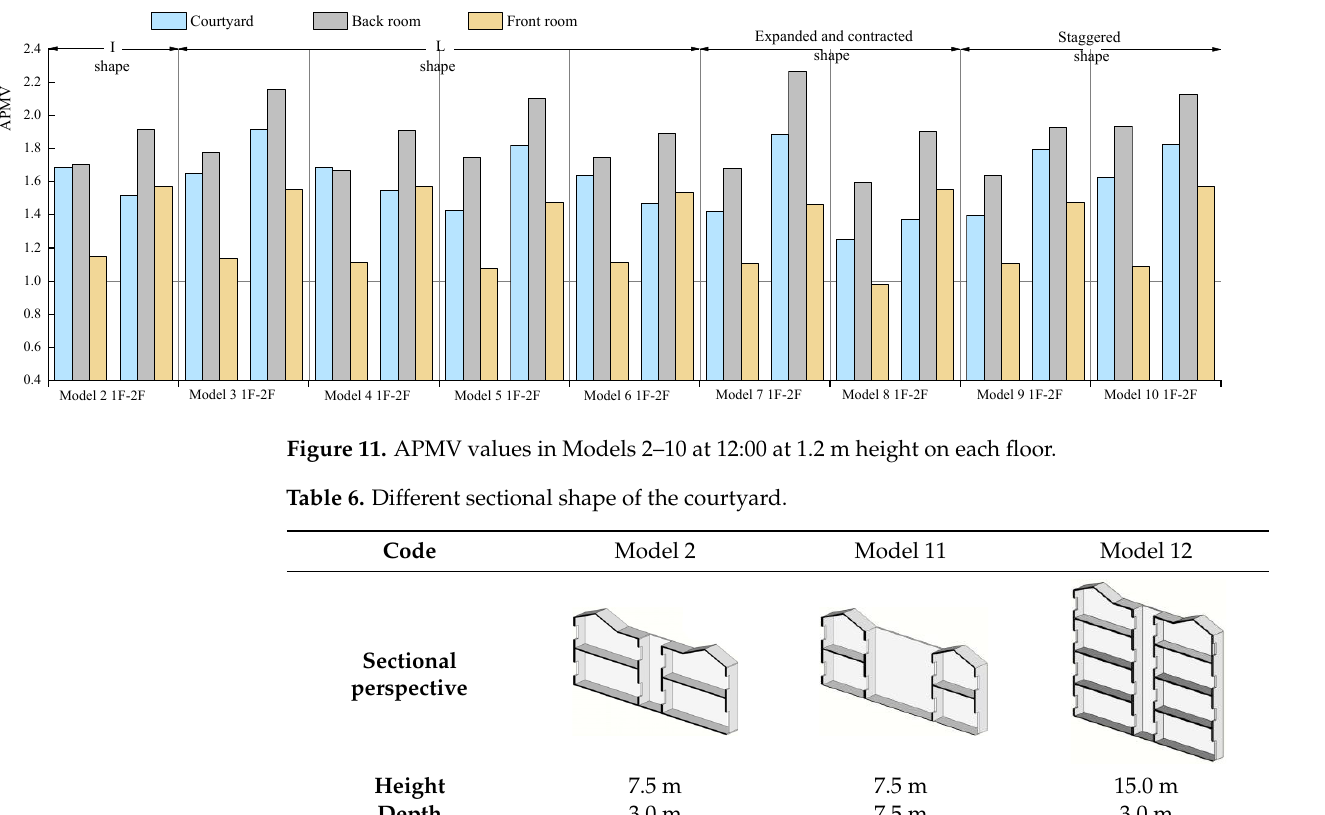
( i ) Model 10 Figure 10. Simulated spatial distributions of T a in Models 2–10 at 12:00 at 1.2 m height on each floor. In group four, the top forward and bottom forward of courtyard sectional staggered shapes in Models 9 and 10 are put forward for simulation. The wind shadow area formed on the north side of Model 10 is larger than the other one. For the natural ventilation of indoor and outdoor spaces on the second floor, Model 10 is significantly better than Model 9, while the result is contrary to that on the first floor. The results indicate that when the staggered courtyard shape is adopted in the design, the top forward type should increase the window-to-ground ratio on the second floor to improve the wind environment. Simi- larly, it also applies to the bottom forward type on the first floor. For the thermal environ- ment, T a in the back room of Model 10 is significantly higher than that of Model 9, both on the first and second floors. Therefore, the APMV of Model 10 is higher than Model 9,